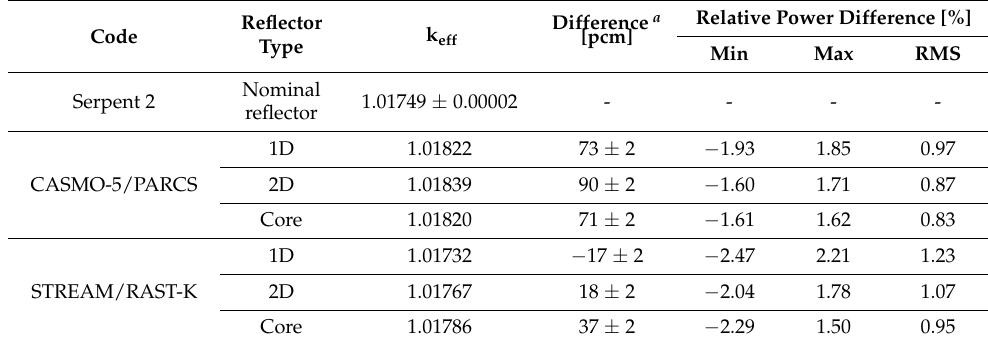
Table 6. Comparison of three different code systems for the 2D Rostov-II